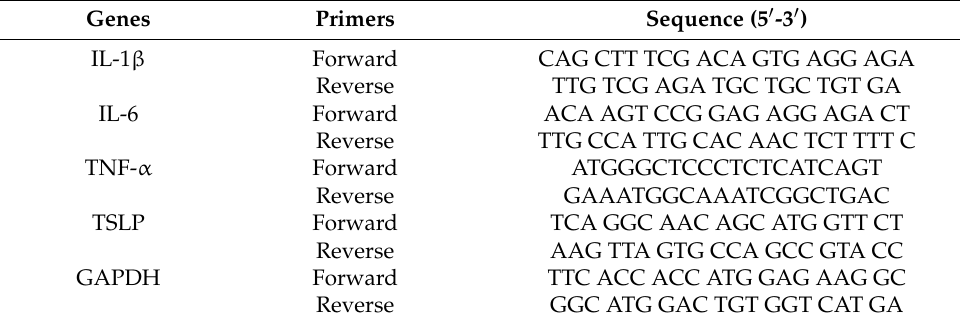
Table 1. Rat primer sequences for RT-qPCR.